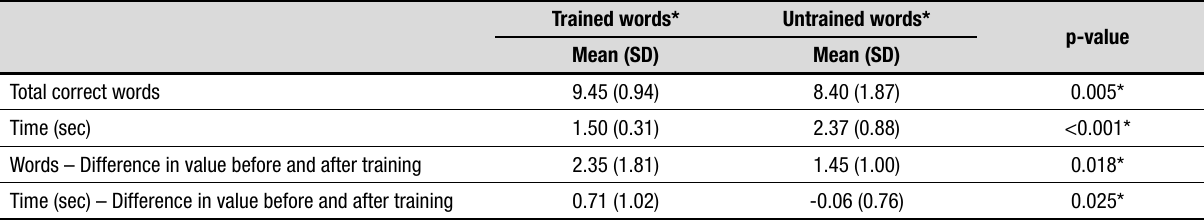
Table 5. Comparison of naming responses of trained and untrained words after